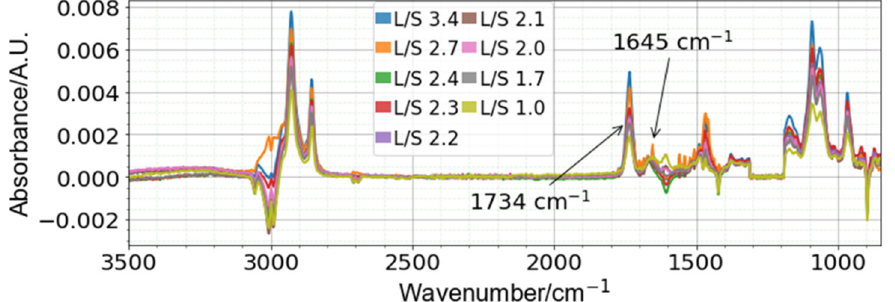
Figure 2. L/S ratio spectra (sample spectra with minimal water vapor present shown) performed at 1 mM SM. The peaks corresponding to 1734 and 1645 cm − 1 correspond to unique DPPC and SM peaks, respectively.